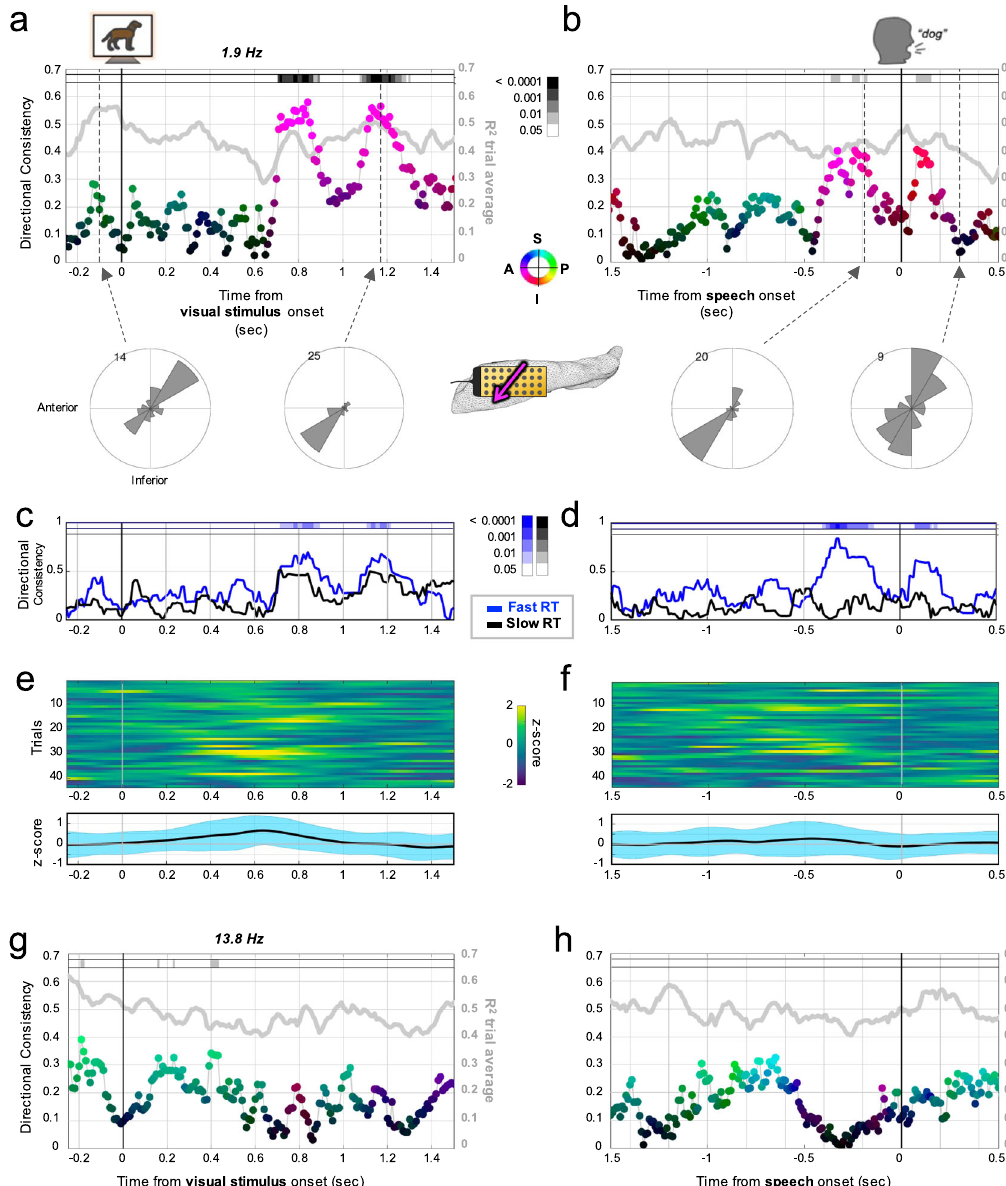
Fig. 3 Alignment of propagation direction across trials during a visual naming task. a Directionality consistency values (DC; dots) across trials for the 1.9 Hz peak frequency in Participant 5 ( n = 43 trials) with timepoints locked to the visual stimulus at time zero, colored as average direction of travel (circular mean, saturation proportional to maximum DC, direction according to color wheel: I: inferior, P: posterior, S: superior, A: anterior) over the hippocampal surface (pixels in lane at top: FDR-corrected Rayleigh test p -value, p FDR ; see scale bar). The propagation strength across trials was estimated by mean R 2 (gray superimposed line: separate y -axis at right) which was roughly similar when trials were aligned in direction or not (high or low DC). Directional distributions are shown below for two example timepoints (dotted lines). Roughly 700 ms after the stimulus waves abruptly begin to align antero-inferiorly across trials (strongest p FDR = 3.2 − 5 , Rayleigh). b DC now locked to speech onset (time zero). Alignment of propagation across trials similar to ( a ) is evident again shortly before speech (strongest p FDR = 0.0243, Rayleigh) and resolves back to baseline levels after speech onset. c Trials in ( a and b ) were grouped by reaction time (fast or slow, median split). Fast reaction time trials increased in DC signi fi cantly after the stimulus (strongest p = 0.0049, Rayleigh; see scale bars) and ( d ) around speech onset (strongest p = 5.6 − 6 , Rayleigh), whereas slow reaction time trials did not (empty FDR FDR p FDR lanes). e Trial rasters of analytic amplitude for the 1.9 Hz frequency described in ( a ), averaged across trials in bottom panel (mean: black trace; blue envelope: standard deviation) with a subtle increase peaking at ~600 ms, returning to baseline as DC in ( a ) begins to increase. f Similar to ( e ) now locked to speech onset (time zero) with amplitude staying roughly at baseline during DC changes in ( b ) (mean: black trace; blue envelope: standard deviation). g , h Illustrate the 13.8 Hz peak frequency (similar to ( a ) and ( b )) in the same participant with limited DC value trends (strongest p FDR = 0.0119, Rayleigh) that dissipate by ~500 ms into